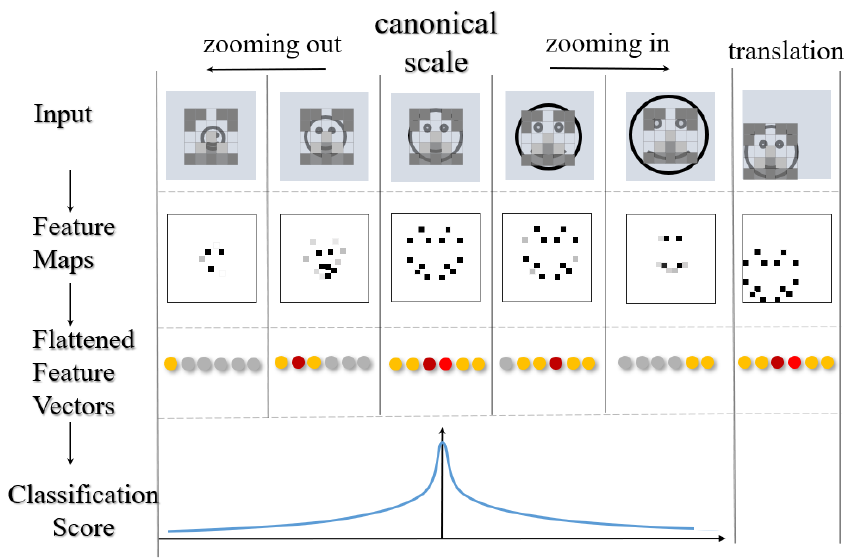
Figure 2. Influence of input deformation on CNN output. Dyadic zooming out uses the discrete-wavelet transform, and non-dyadic zooming out uses the result of the next-level discrete-wavelet transform that is zoomed in by bilinear interpolation. Then, the image pyramid with different scales is sent to the multi-channel Siamese CNN with weight sharing for inferencing. A two-dimensional classification-score matrix is obtained. The classification and scale estimation can be simultaneously carried out by the position of the maximum value of the classification-score